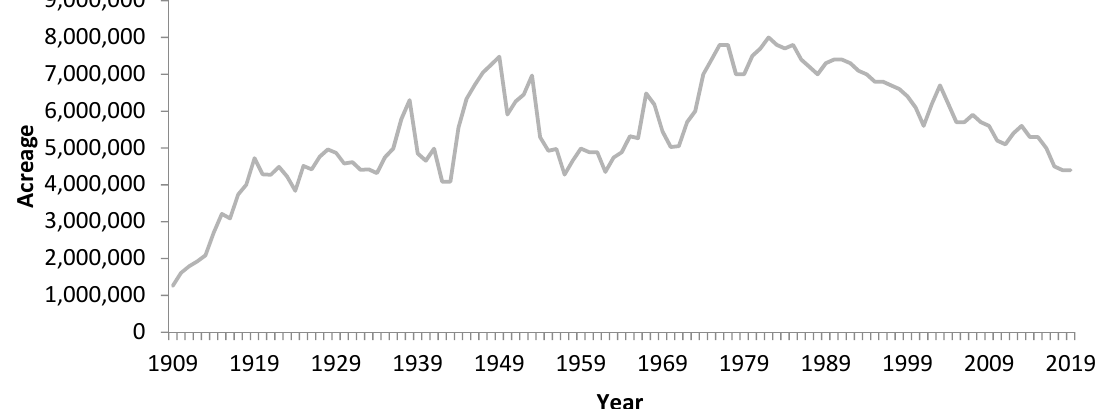
Figure 2. Wheat planted acreage in Oklahoma from 1909 to 2018. Source: USDA-NASS Quickstats 2018 [22].